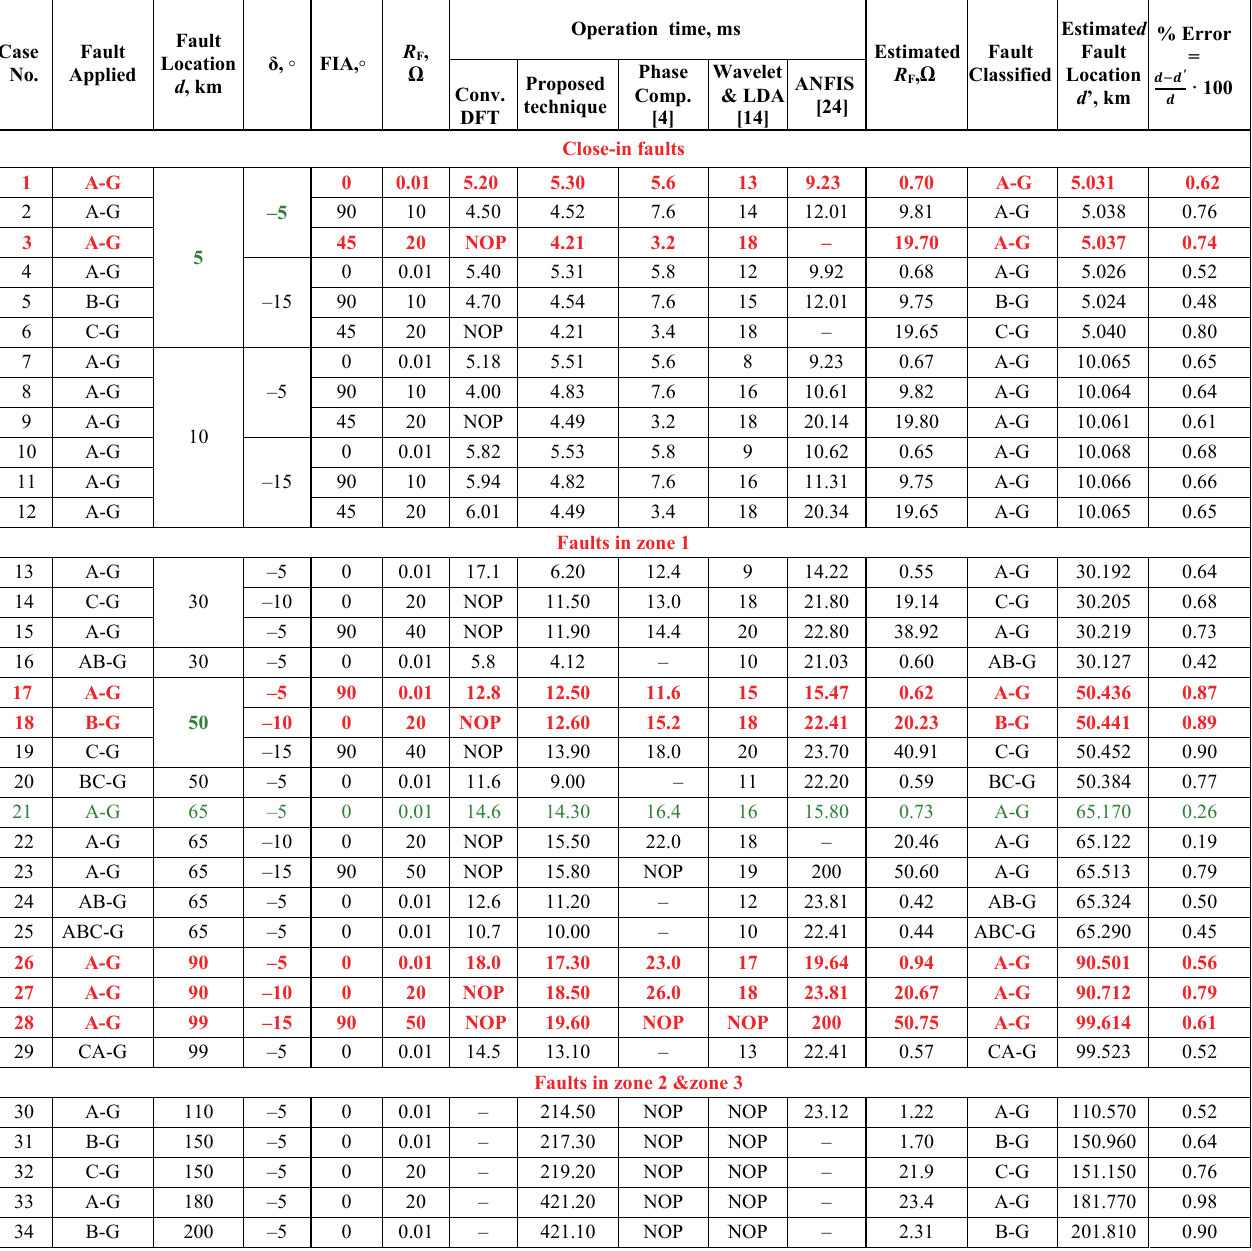
Table I. The effect of DC component will be profound during the low fault resistance and vanish during the high fault resistance, which can be observed from Figures 9(b) and 10(b). The adaptive setting of the numerical relay is highly effective for the protection scheme under